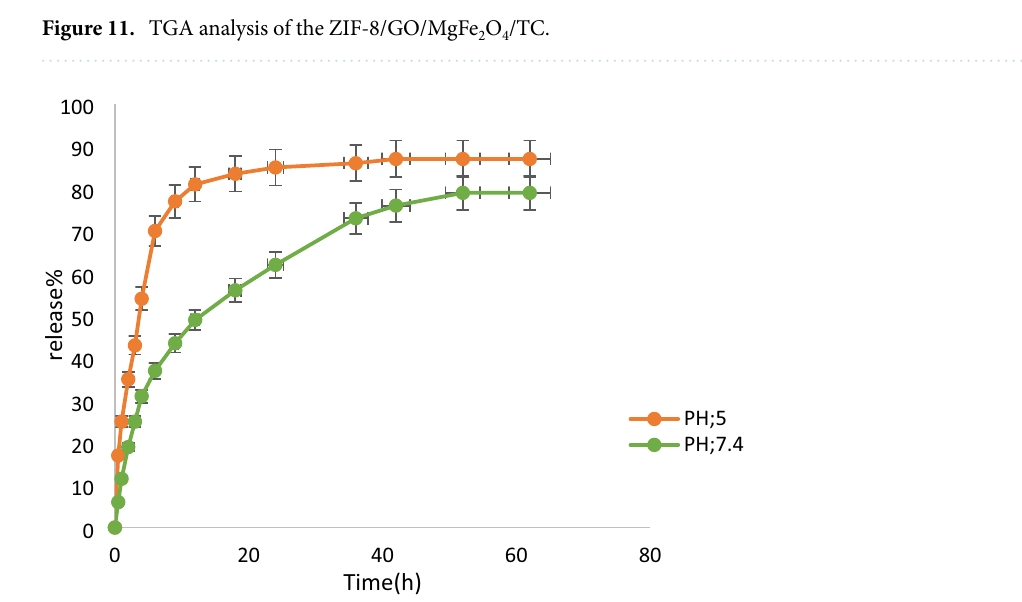
Figure 12. TC release from ZIF-8/GO/MgFe 2 O 4 in acetate buffer and phosphate buffer